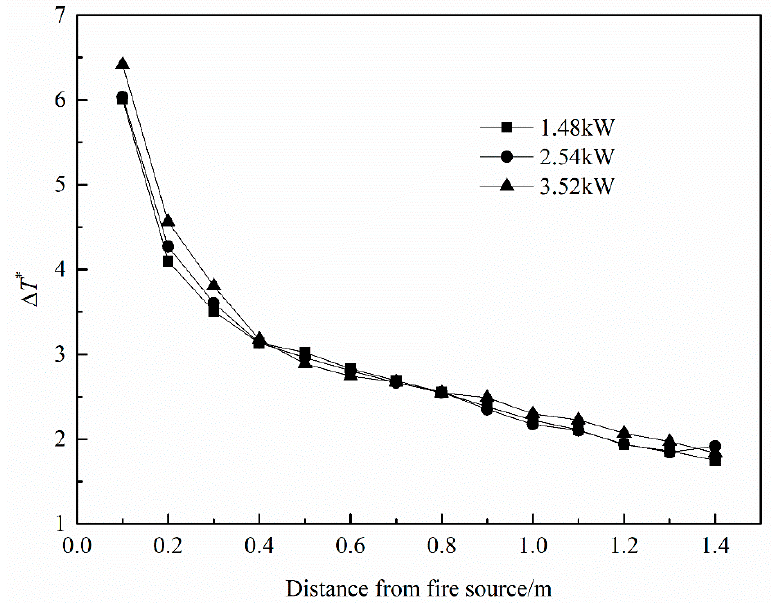
Figure 7. Effect of heat release rate on the dimensionless smoke temperature rise in the fire section.